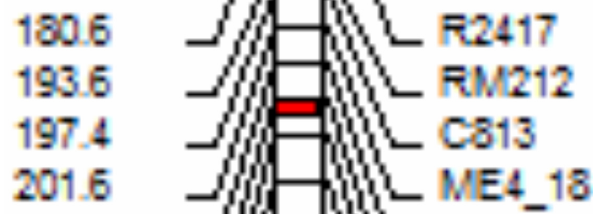
Fig 3. Location of common QTL (red band in axis) for grain yield on rice chromosome 1 (partly shown) detected by MIM across two